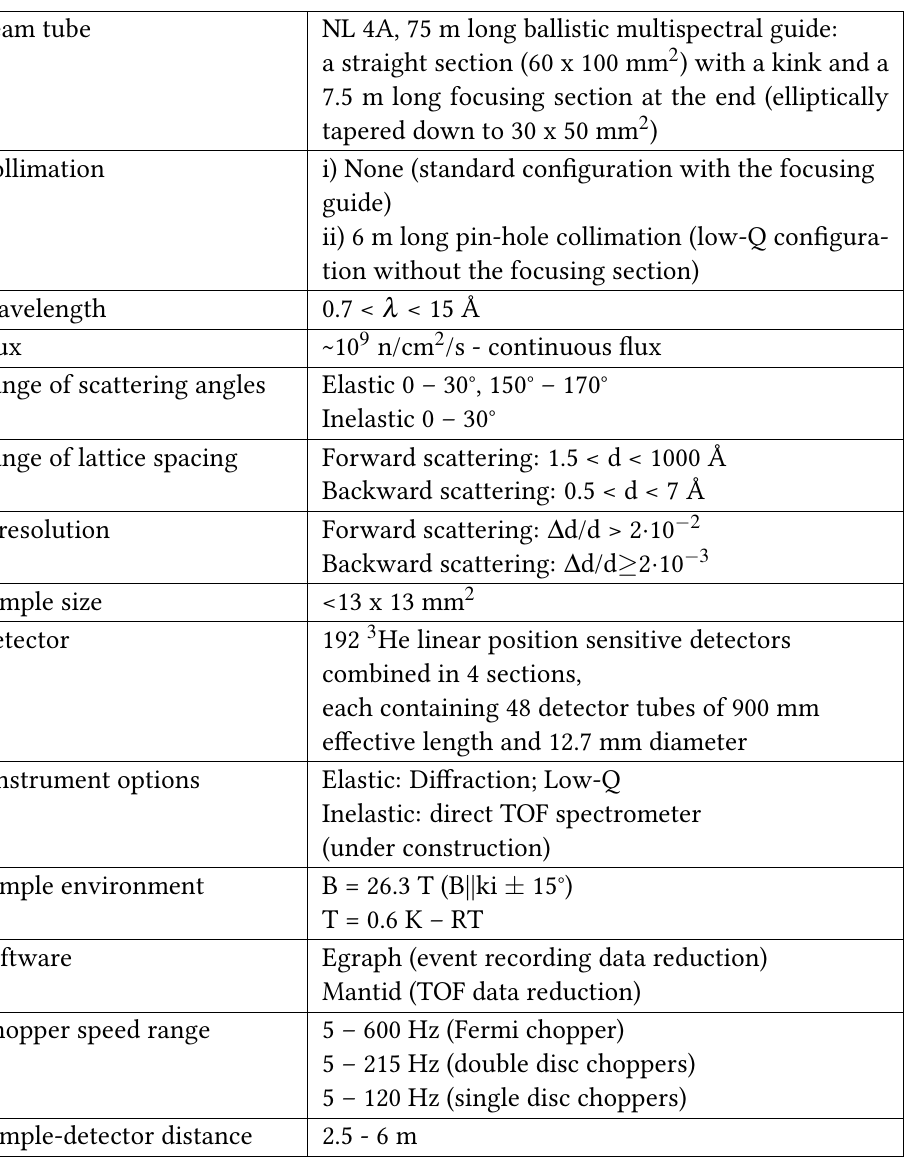
Table 2: Technical parameters of